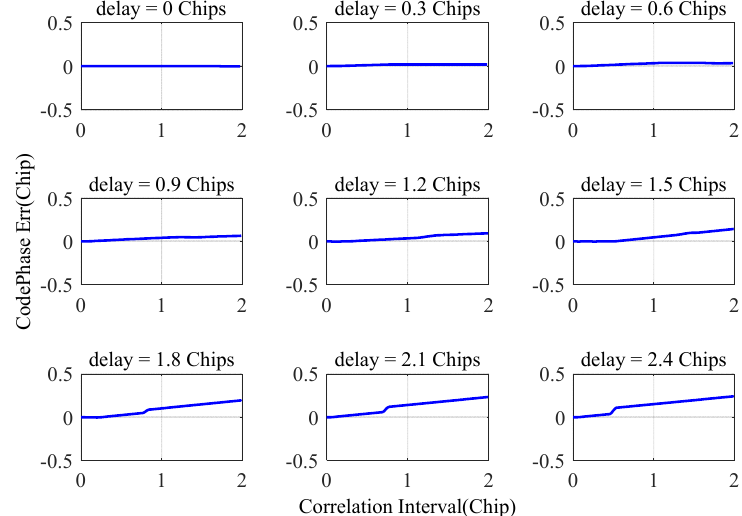
Figure 10. Impact of pull-off spoofing interference on SCB.